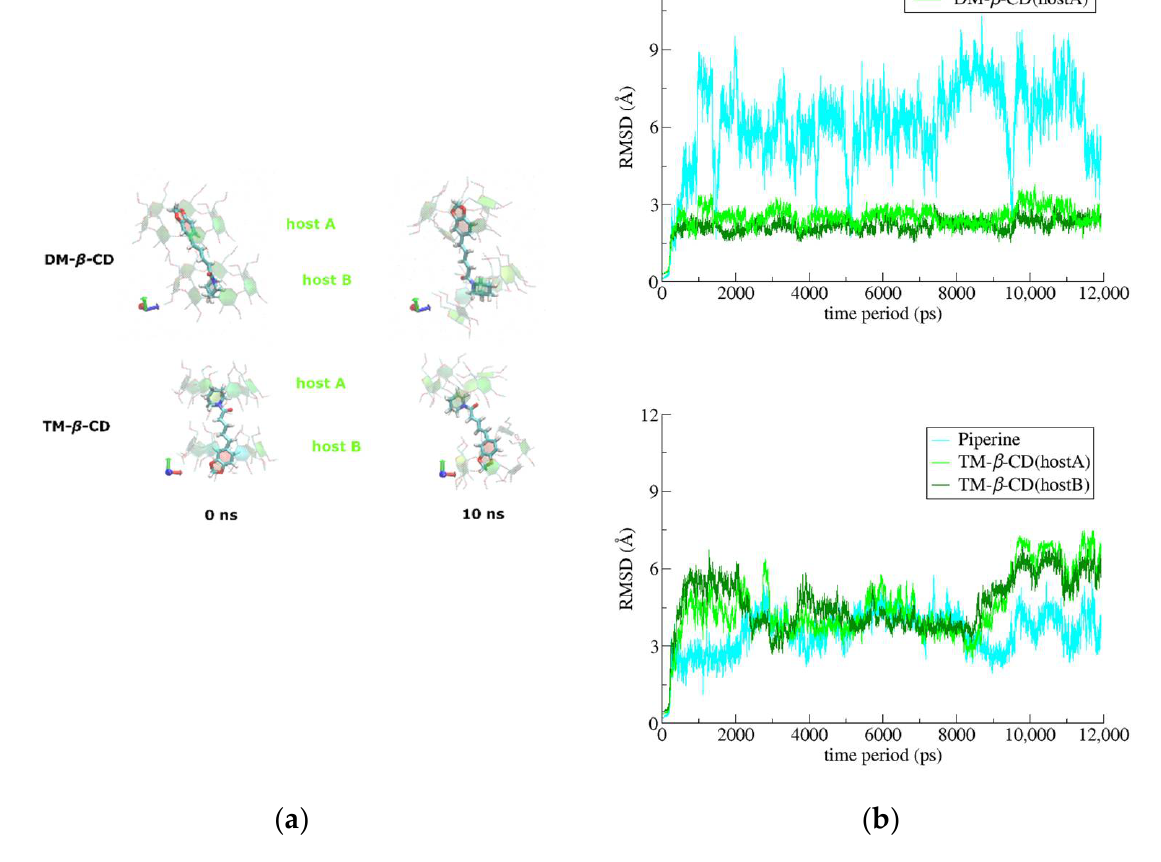
Figure 7. ( a ) Representative snapshots of PN/DM- β -CD and PN/TM- β -CD inclusion complexes at 0 and 10 ns. ( b ) RMSD to the first frame for the inclusion complexes of PN/DM- β -CD (1:2), PN/TM- β -CD (1:2) as a function of MD simulations time.